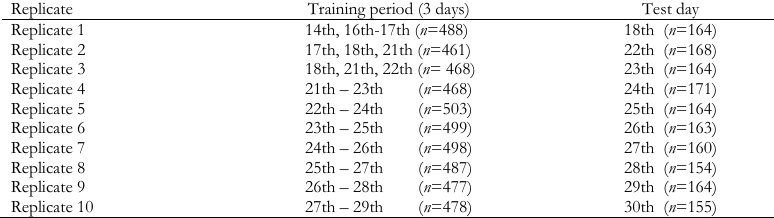
Training period and test day (in calendar days of June 2000), for the 10 replicates of the simulation. n denotes the number of sea-level pressure observed values